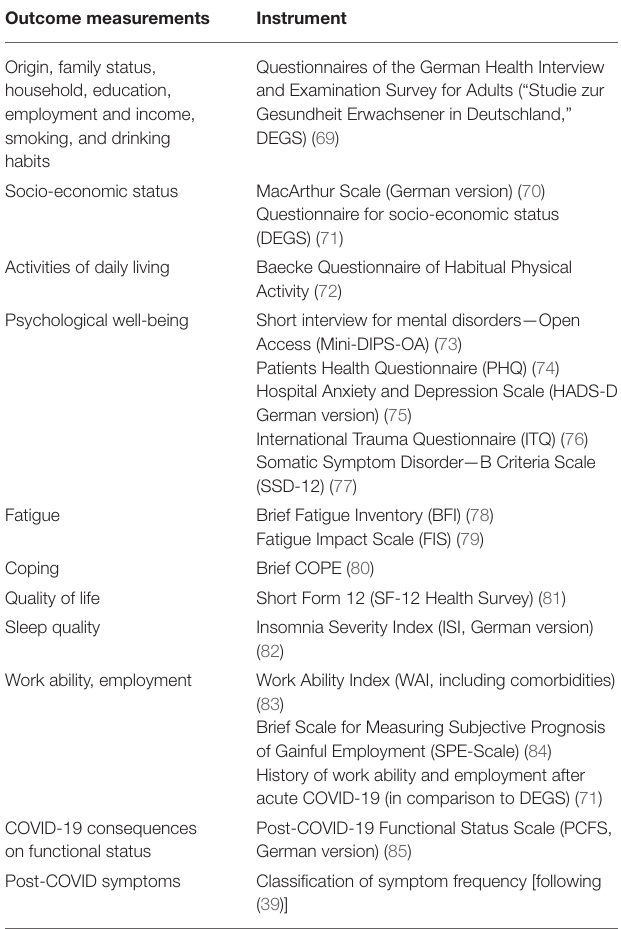
TABLE 1 | Outcome measurements in the self-administered questionnaire. Outcome